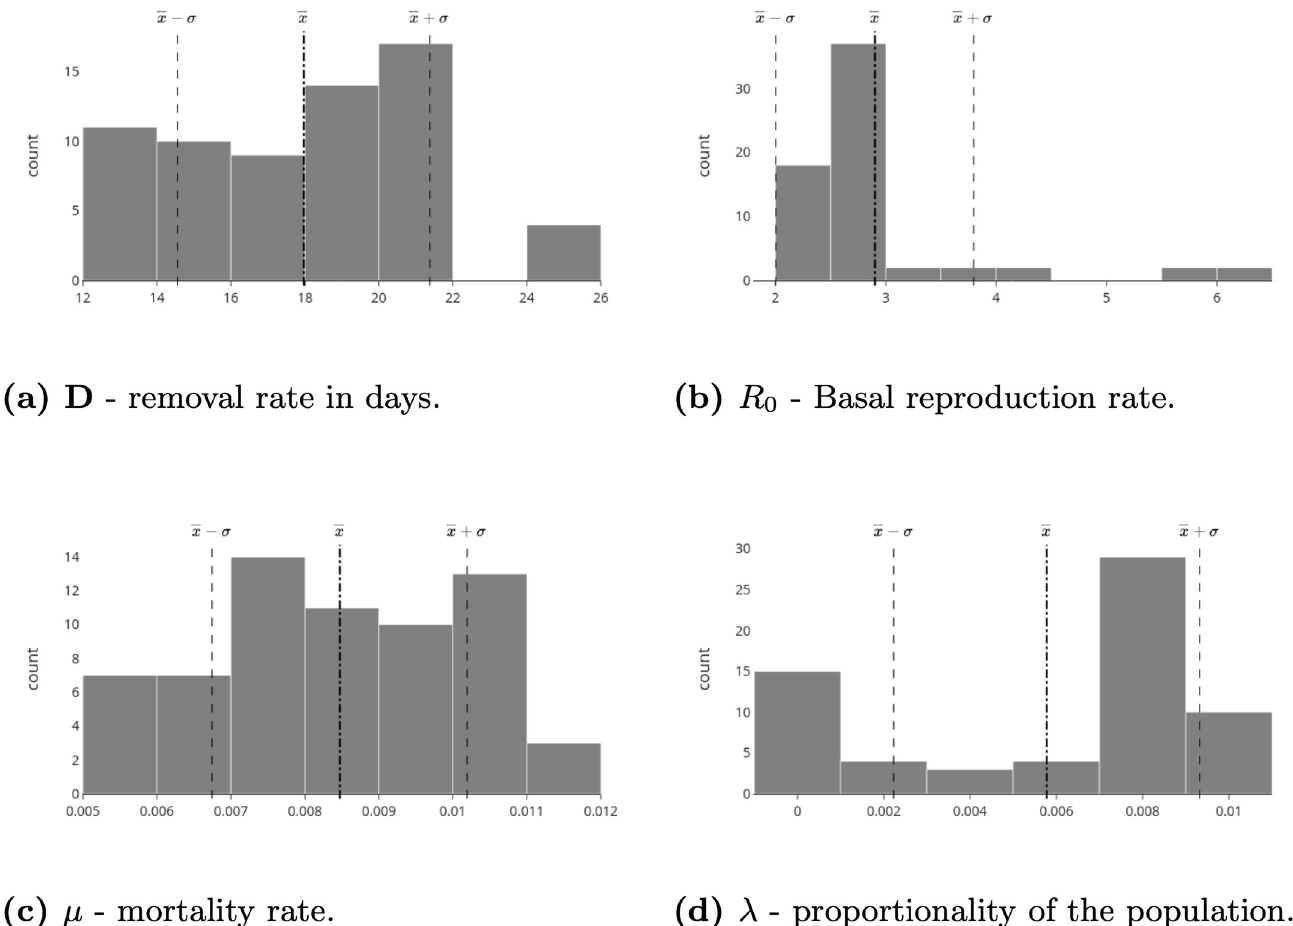
Fig 7. Distributions of the estimated parameters D , R 0 , μ e λ , accumulated since the beginning of the pandemic, for all Brazilian states. (a) Distribution of the estimated recovery rate in days: D − � X ¼ 17 : 97 � s ¼ 3 : 41 . (b) Distribution of the estimated basic reproductive rate: R 0 − � X D D Distribution of the estimated mortality rate: μ − � X ¼ 0 : 8% � s ¼ 0 : 2% . (d) Distribution of the proportionality rate of the estimated population: λ − m m � X ¼ 0 : 6% � s ¼ 0 : 4% l l